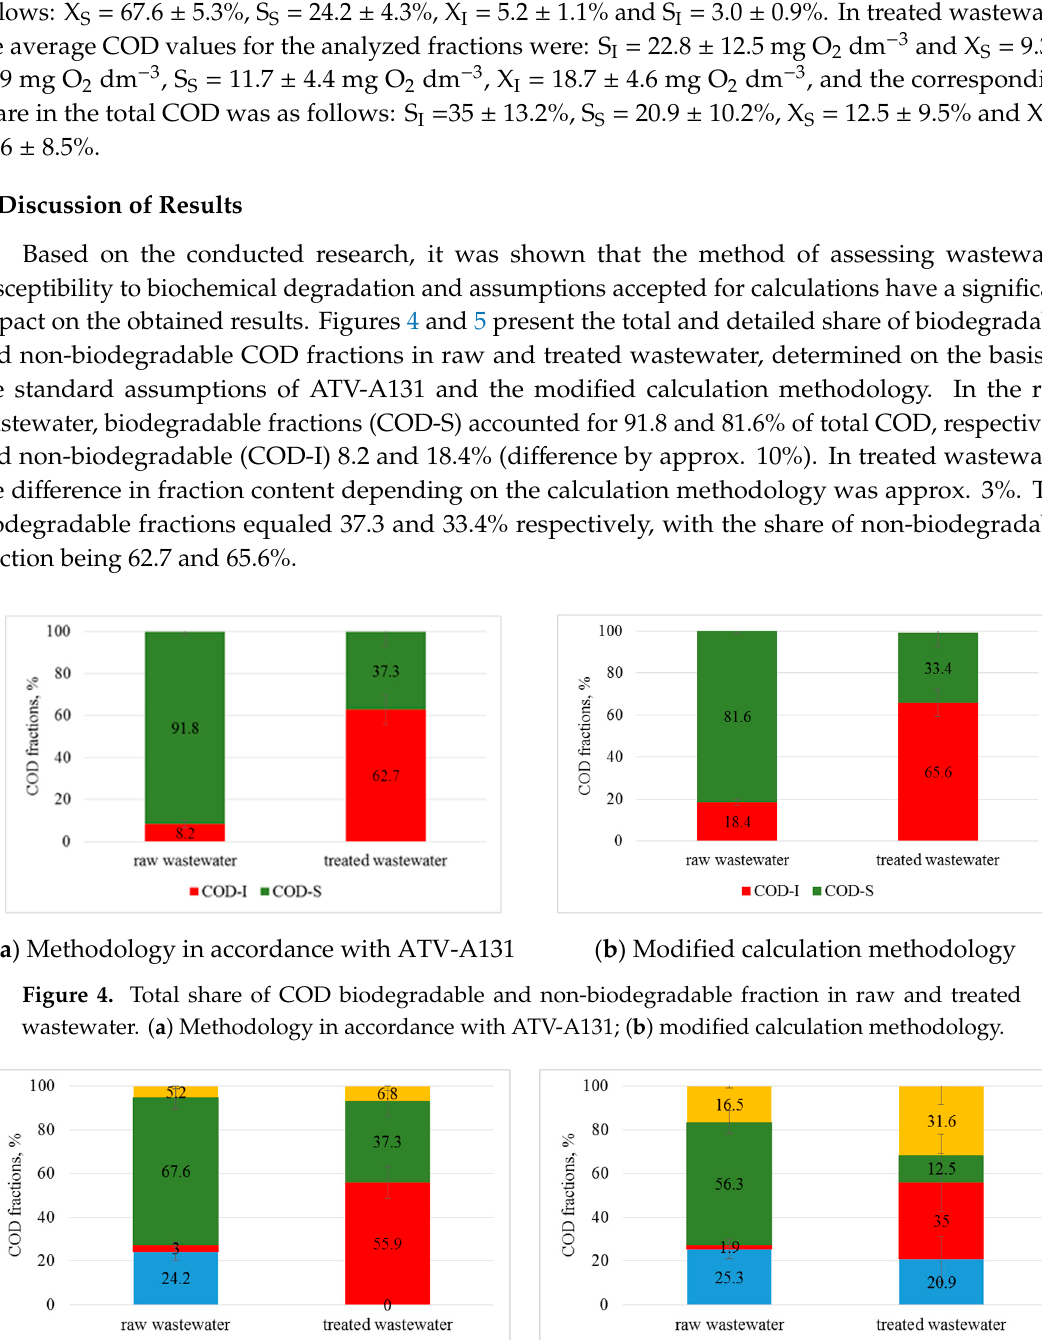
Figure 5. Average fraction shares in total COD of raw and treated wastewater. ( a ) Methodology in accordance with ATV-A131; ( b ) modified calculation methodology.